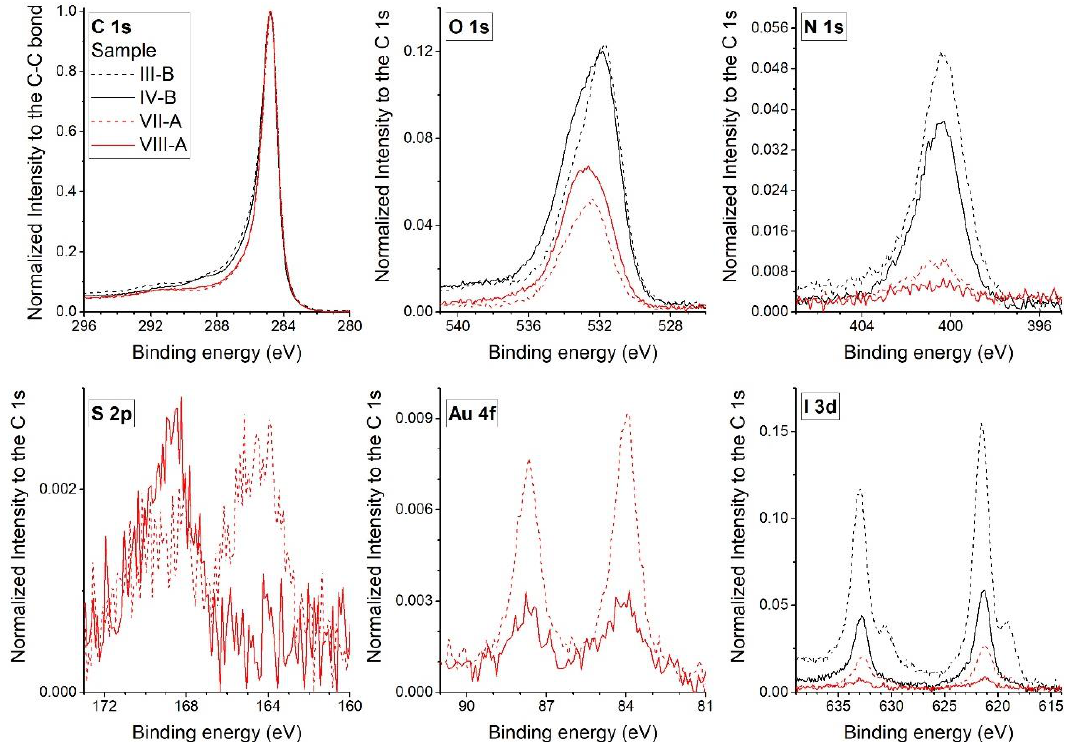
Figure 2. XPS of C 1s, O 1s, N 1s, S 2p, Au 4f, and I 3d core level spectra of III B , IV B , VII A , and VIII A compounds.